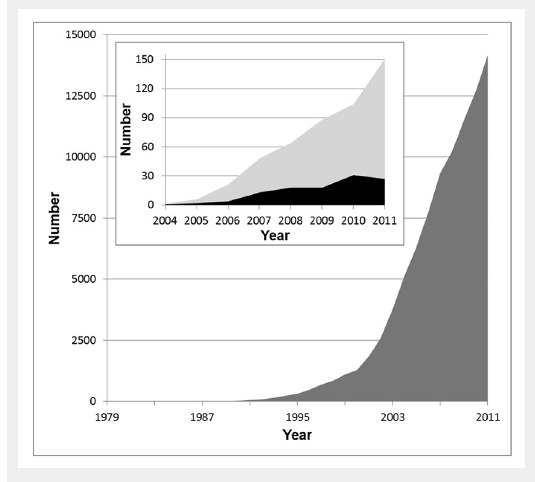
The number of publications in the field of nanotechnology is increasing exponentially. The dark grey area in the main graph depicts the publications per year listed in the ISI Web of Knowledge database (all databases) for the search term “nano”. In the inset, the light grey area shows the search result for the keyword “nanotoxicology” and the black area the hits for “nanotoxicology AND